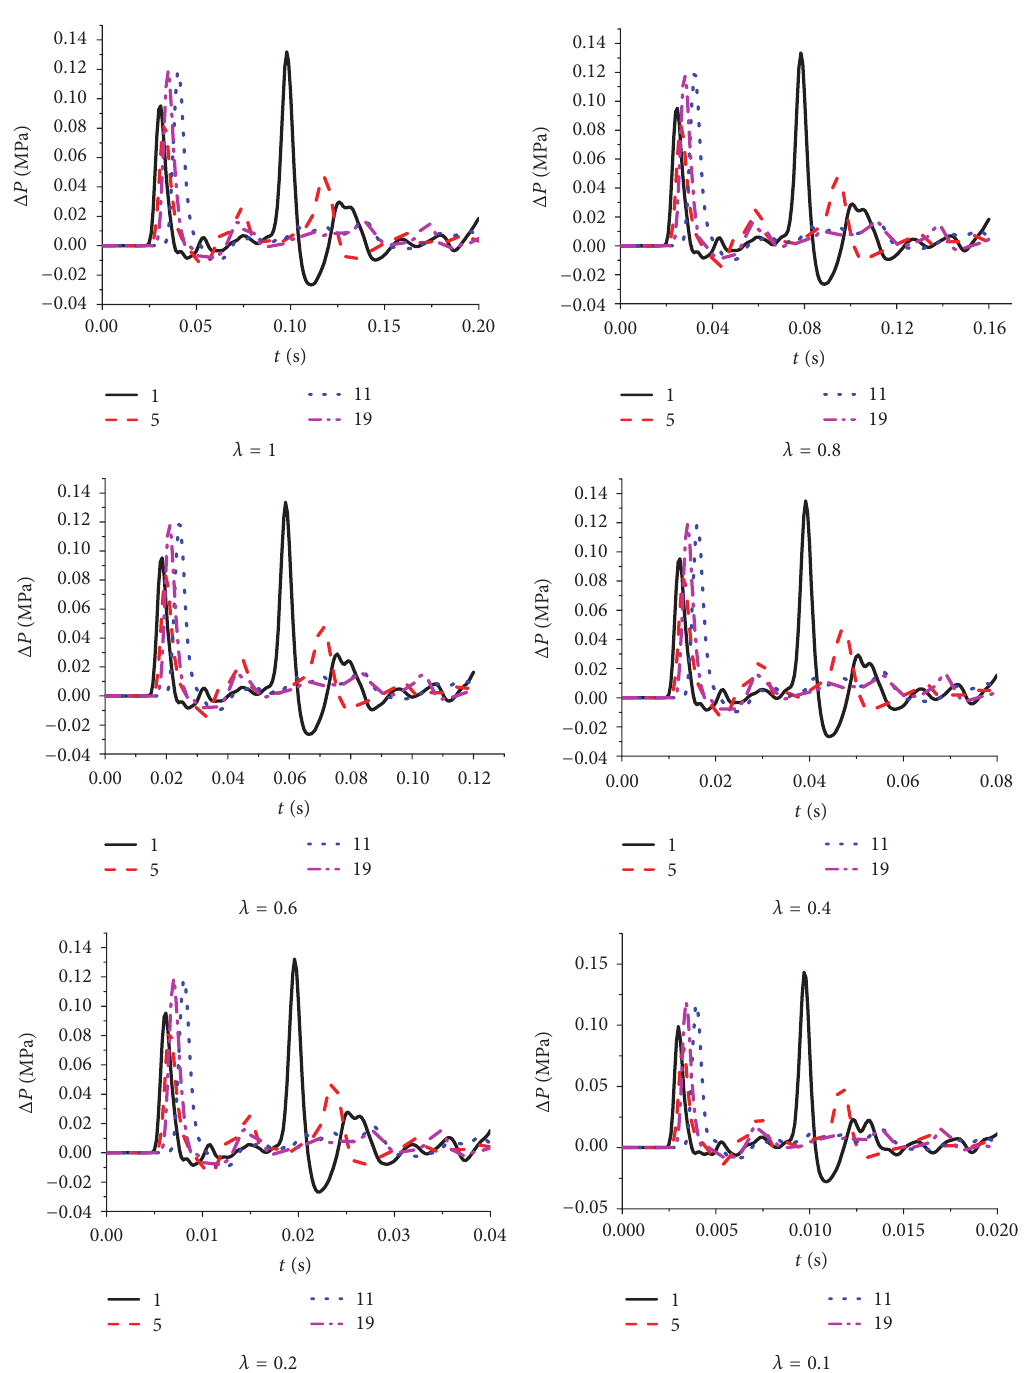
Figure 14: Typical location pressure time-history diagram of each scale